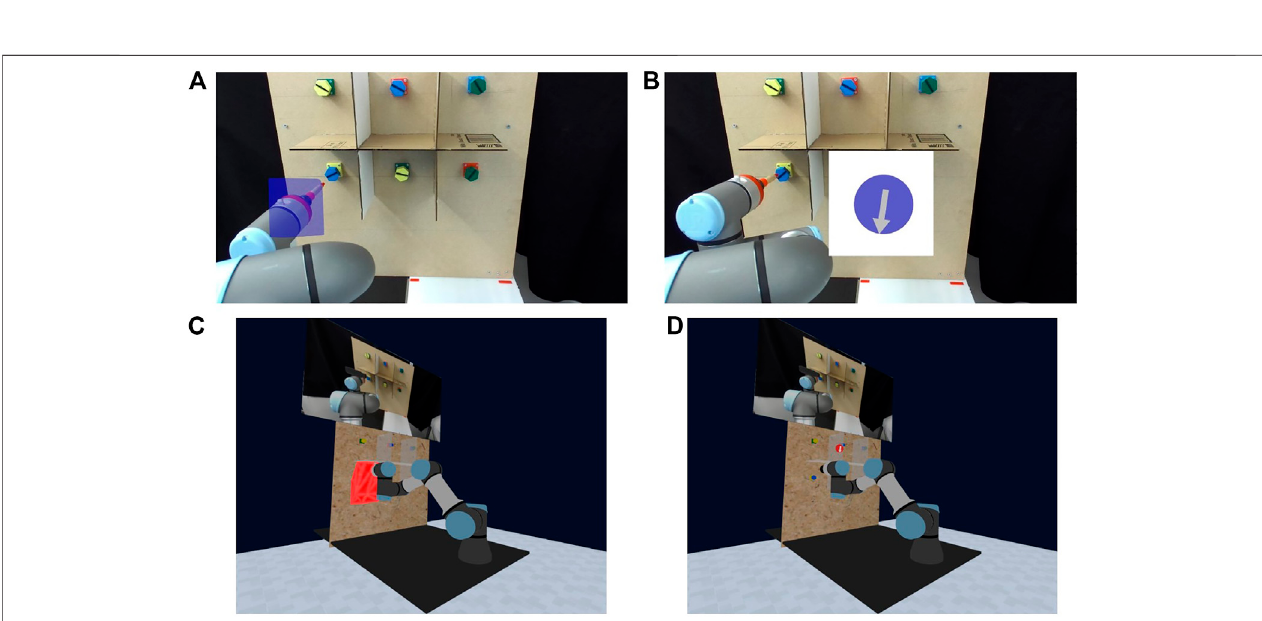
FIGURE 4 | Four prototypes of visualizations for the virtual reality interface. (A) Camera + Polytope (B) Camera + Compass (C) Model + Polytope (D) Model + Compass.